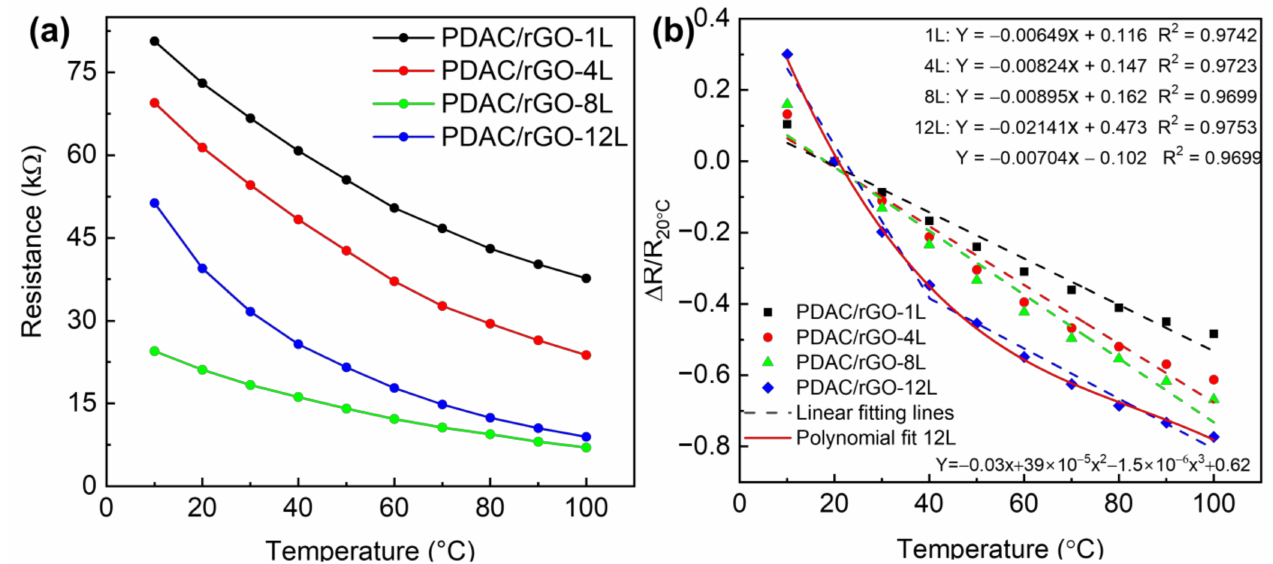
Figure 2. Static thermal properties of PDAC/rGO sensors: ( a ) Resistance of PDAC/rGO sensors and ( b ) sensitivity of